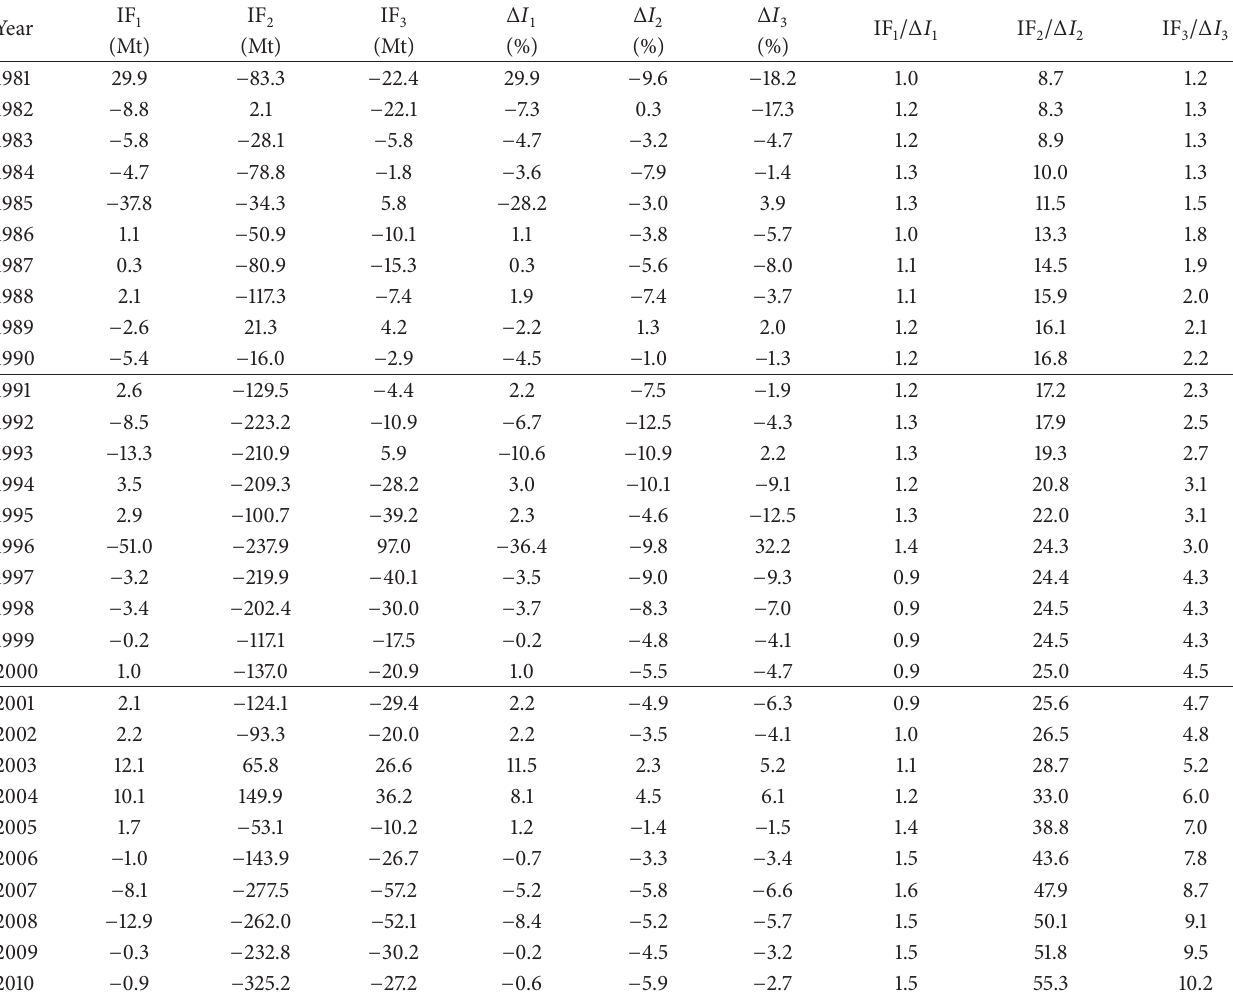
Table 7: Decomposition results of efficiency factor